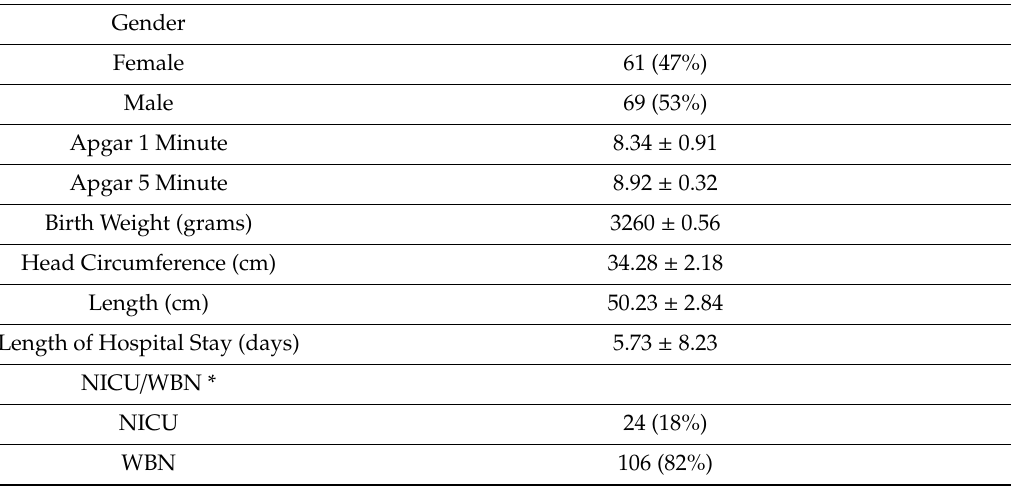
Table 4. Fetal Information. Reported mean ± standard deviation (SD) for continuous variables or n (%) for categorical variables. 95% confidence